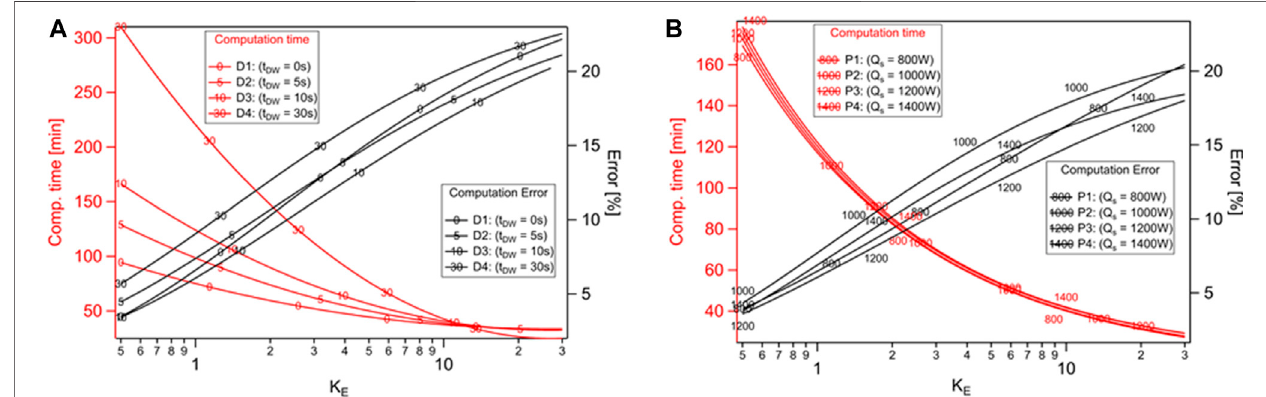
FIGURE10| EffectofK E oncomputationtimeandaccuracyofthenumericalmodelwiththeelongatedellipsoidheatsource (A) D1-D4(effectofdwelltime), (B) P1- P4 (effect of laser power).